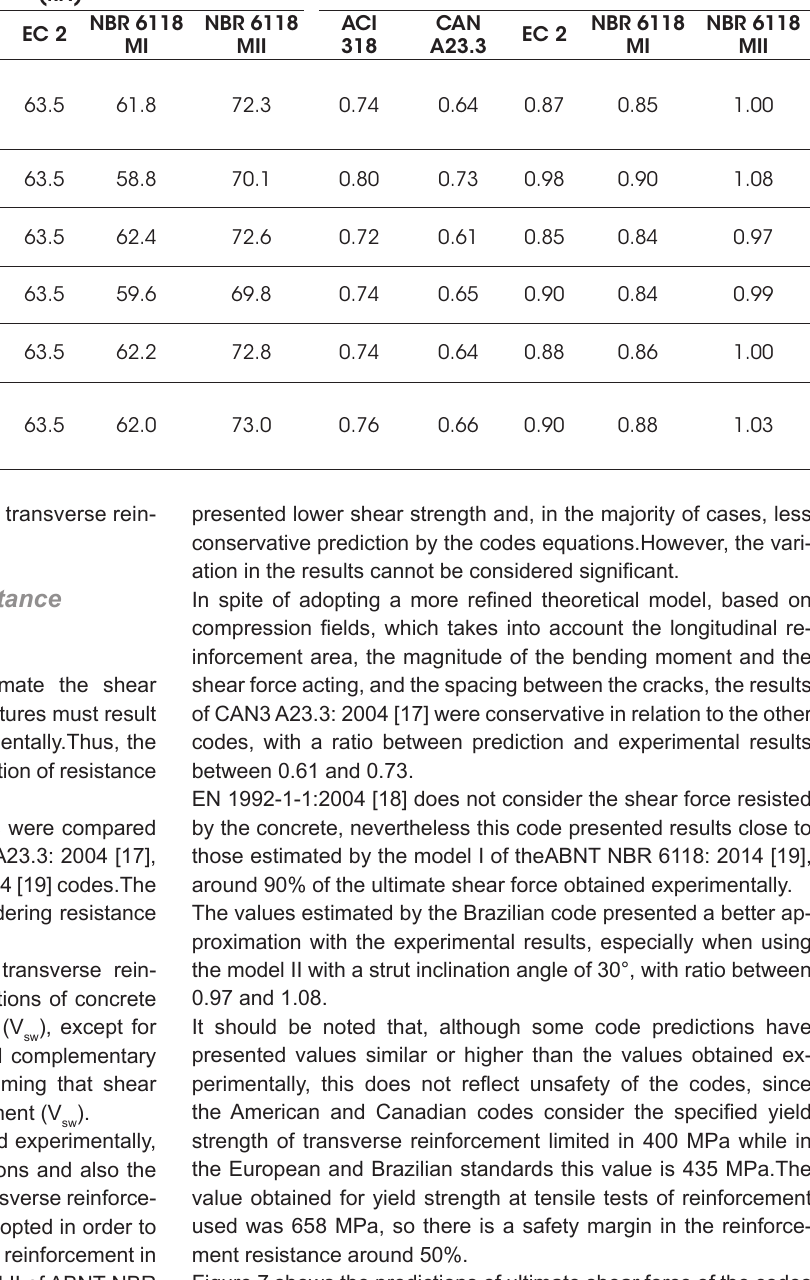
Table 6 Ultimate shear load from experiments, code based prediction and these values ratio